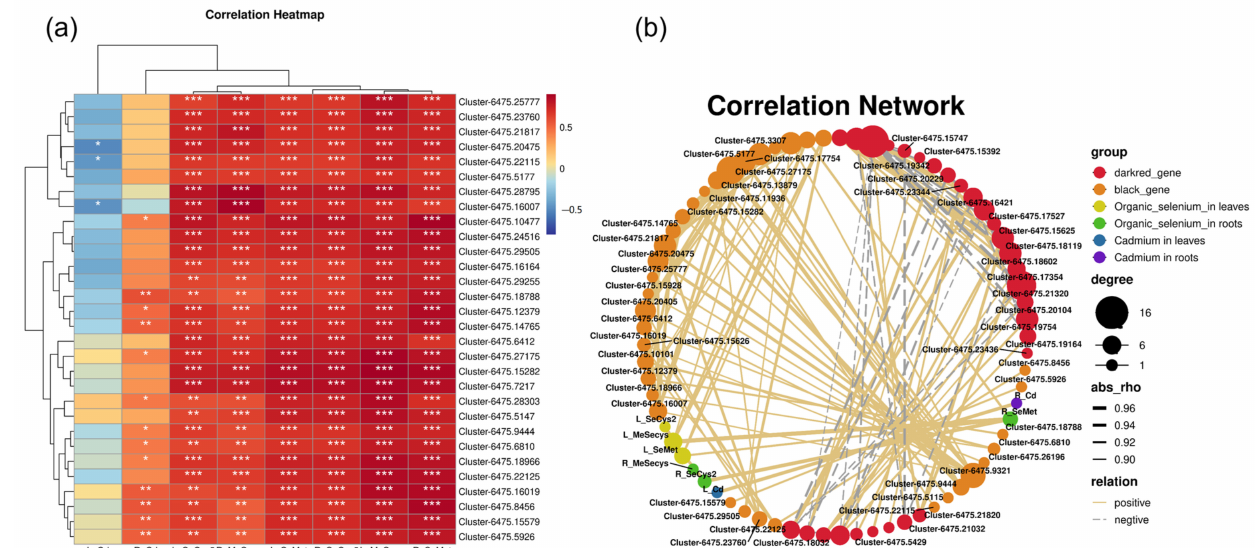
Figure 12. The correlation heat map and network relationships between gene expression patterns and Se forms and Cd contents in Black and Darkred modules. ( a ) Heat map of the correlation coefficient between different Se forms and Cd contents and module characteristic genes; red and blue blocks represent positive and negative correlation, respectively. The white asterisk represents a significant analysis of correlation, where * represents <0.5, ** represents <0.1, and *** represents <0.05. ( b ) Regulating network between the selected hot genes and different Se forms and Cd compounds in B. juncea seedlings. The positive correlation threshold was set to be greater than or equal to 0.5, the negative correlation threshold was set to be less than or equal to − 0.5, and the p -value threshold was less than 0.5, R version 3.6.1,